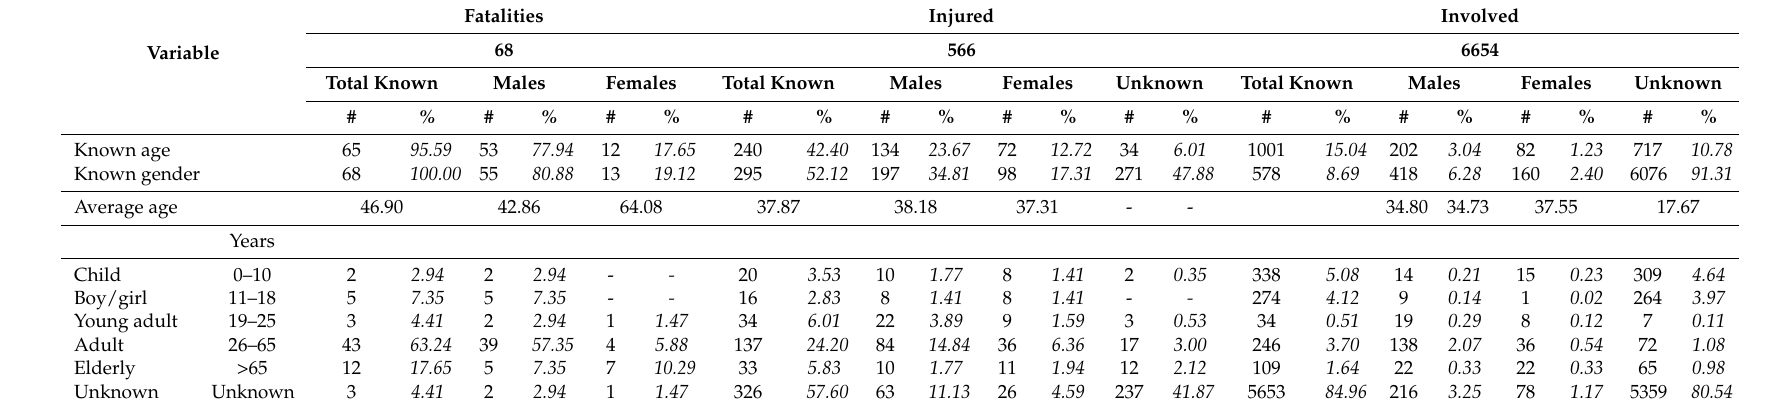
Table 5. Age and gender of fatalities, injured and involved people.